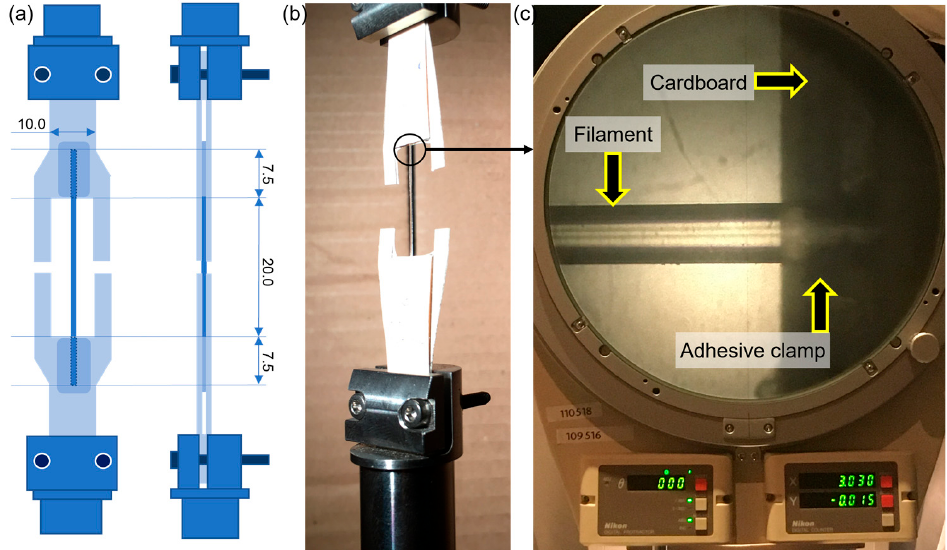
Figure 3. Clamps setup used for the mechanical testing of 1D-printed PLA filaments. ( a ) Scheme of the setup, ( b ) picture of an actual sample prior to testing, ( c ) profilometer detail of the filament, cardboard, and adhesive clamp.